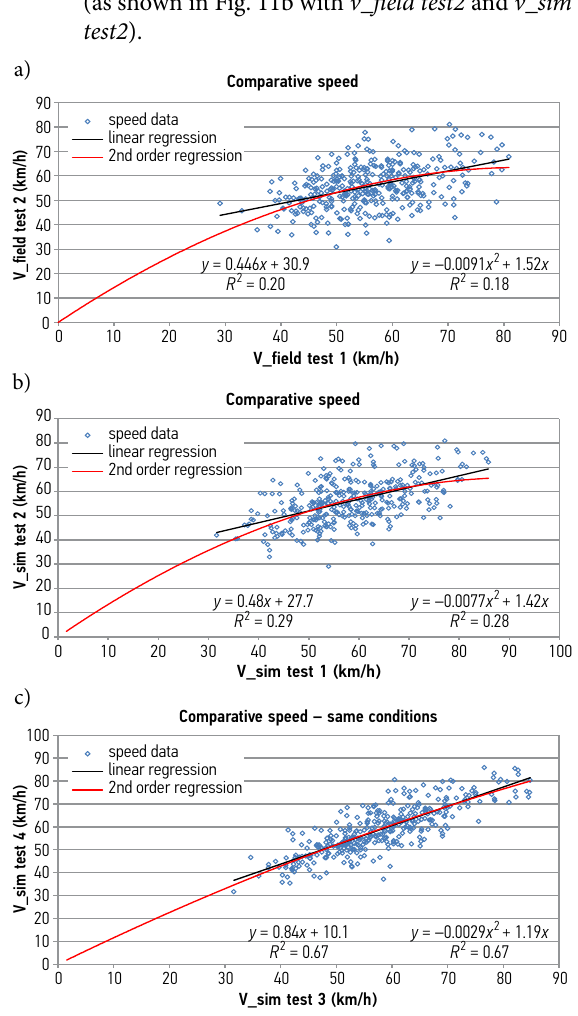
Fig. 11. Comparison in speed among two tests under different boundary conditions: a – with instrumented vehicle; b – with driving simulator; c – with driving simulator under same boundary